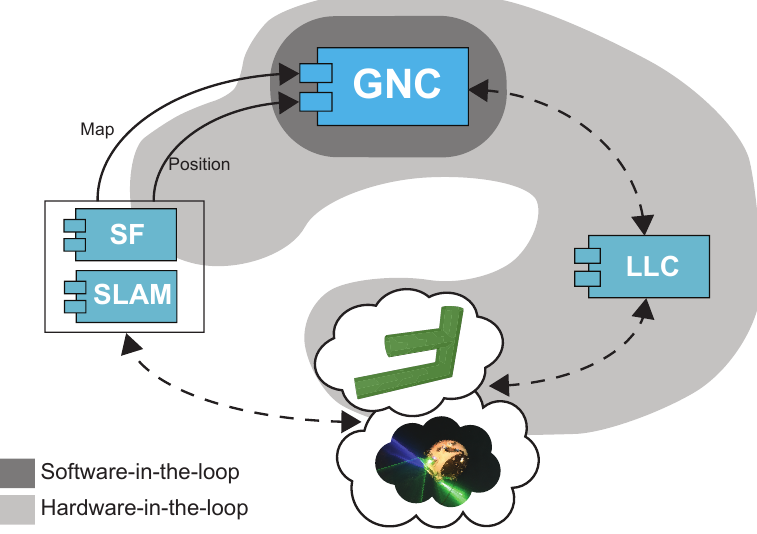
Figure 7. Visual depiction of the SIL and HIL testing